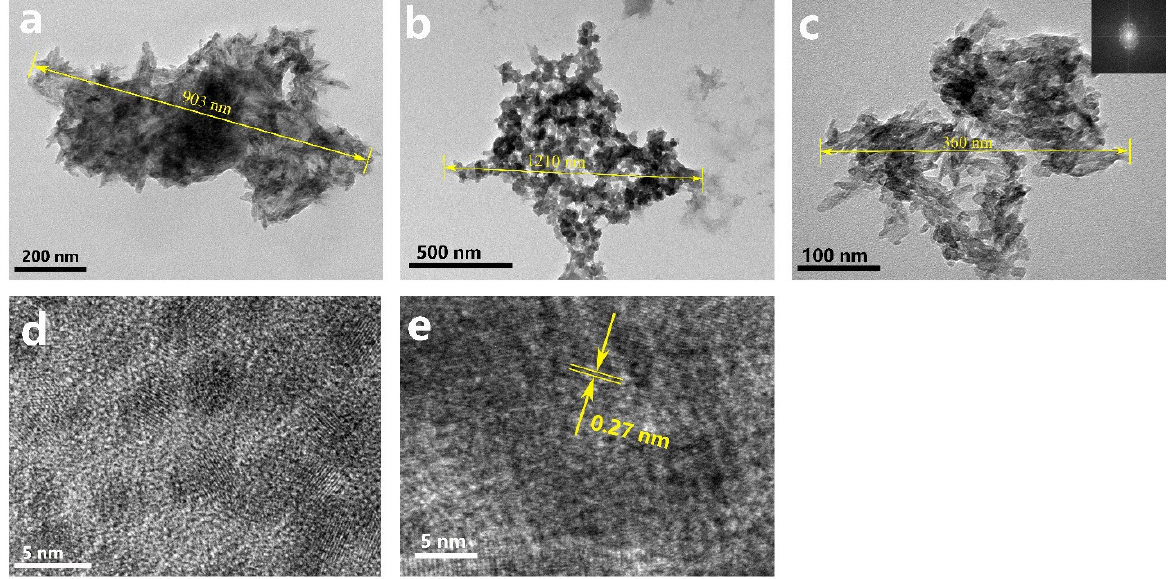
Figure 3. TEM images of ( a ) CT sample, ( b ) TEA+RO sample, and ( c ) TEA+ET sample, and ( d , e ) HRTEM image of TEA+ET sample, detection immediately after preparation.